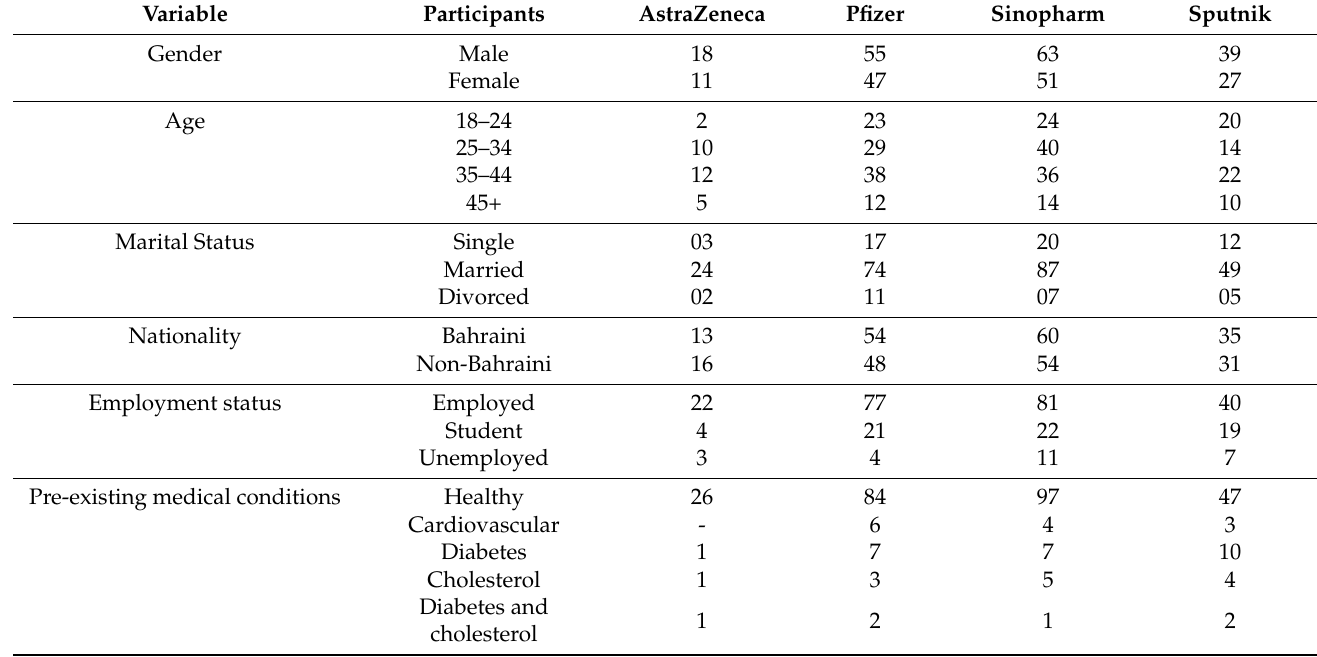
Table 1. Characteristics of participants who received both doses of different